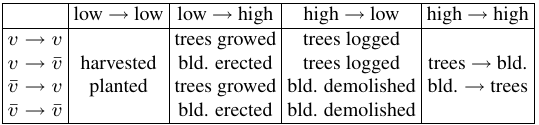
window around ( x, y ) .